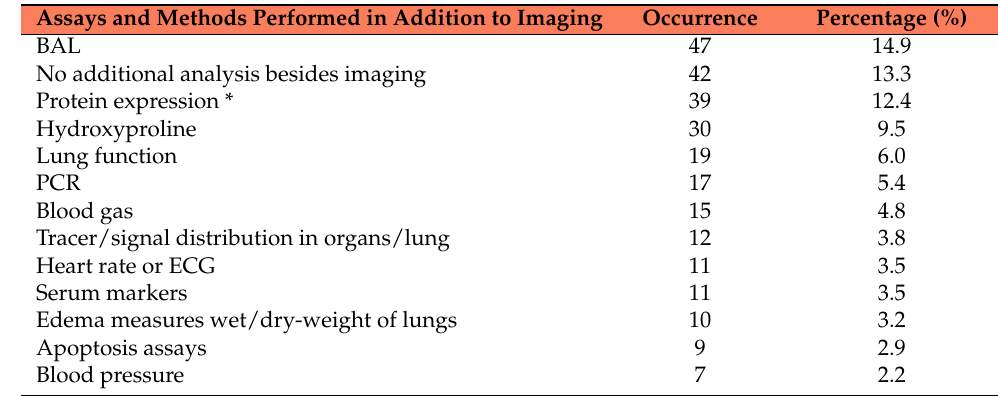
Table 7. Invasive or terminating analyses performed for conformational and complementary purpose to the imaging data. Occurrence indicated presence of analyzing method, where several techniques could be used within one article. The second part of the table presents the different staining techniques and how frequently they were employed. * indicate protein expression assays, including both enzyme-linked immunosorbent assay (ELISA)-based analyses and use of the Western blot technique. Assays and Methods Performed in Addition to